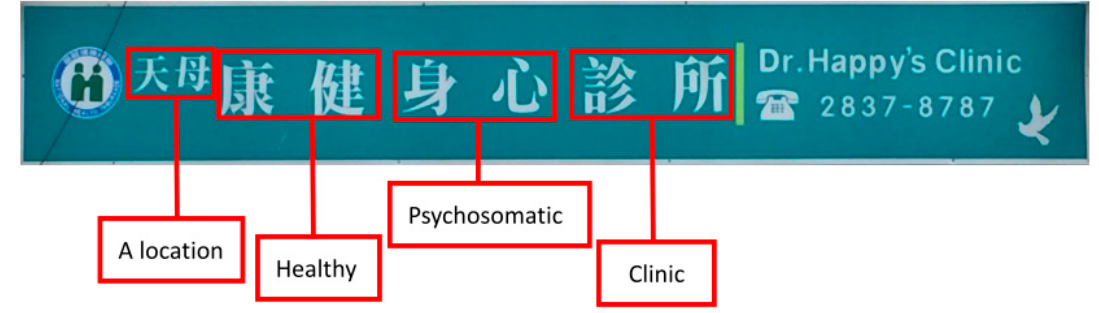
Figure 1. An example of a registered clinic name in Taiwan.